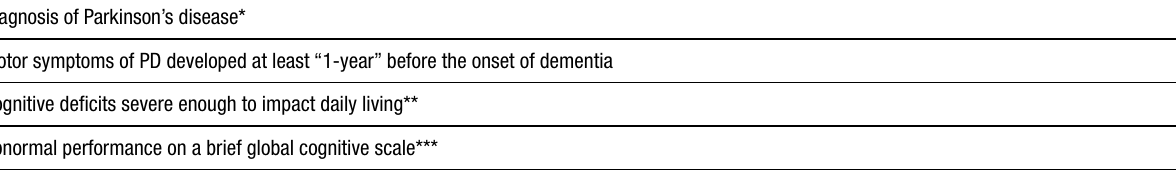
Table 3. Modified algorithm for diagnosing Parkinson’s disease dementia at Level I. Diagnosis of Parkinson’s